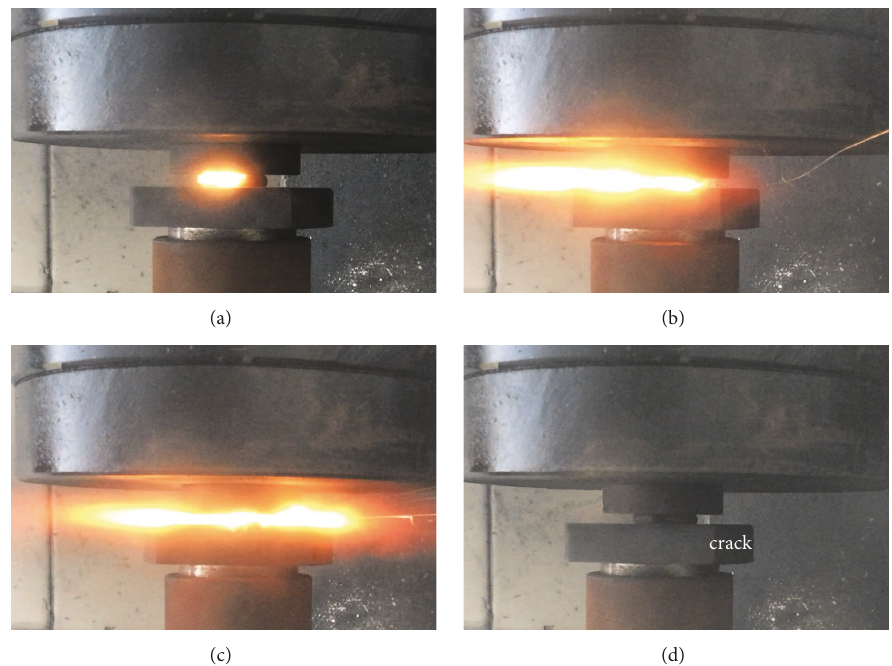
Figure 5: The initiation process of a type B specimen. (a) First sign of initiation, (b) reaction propagated from the edge to the interior of the specimen, (c) violent reaction, and (d) after initiation and the formed crack.